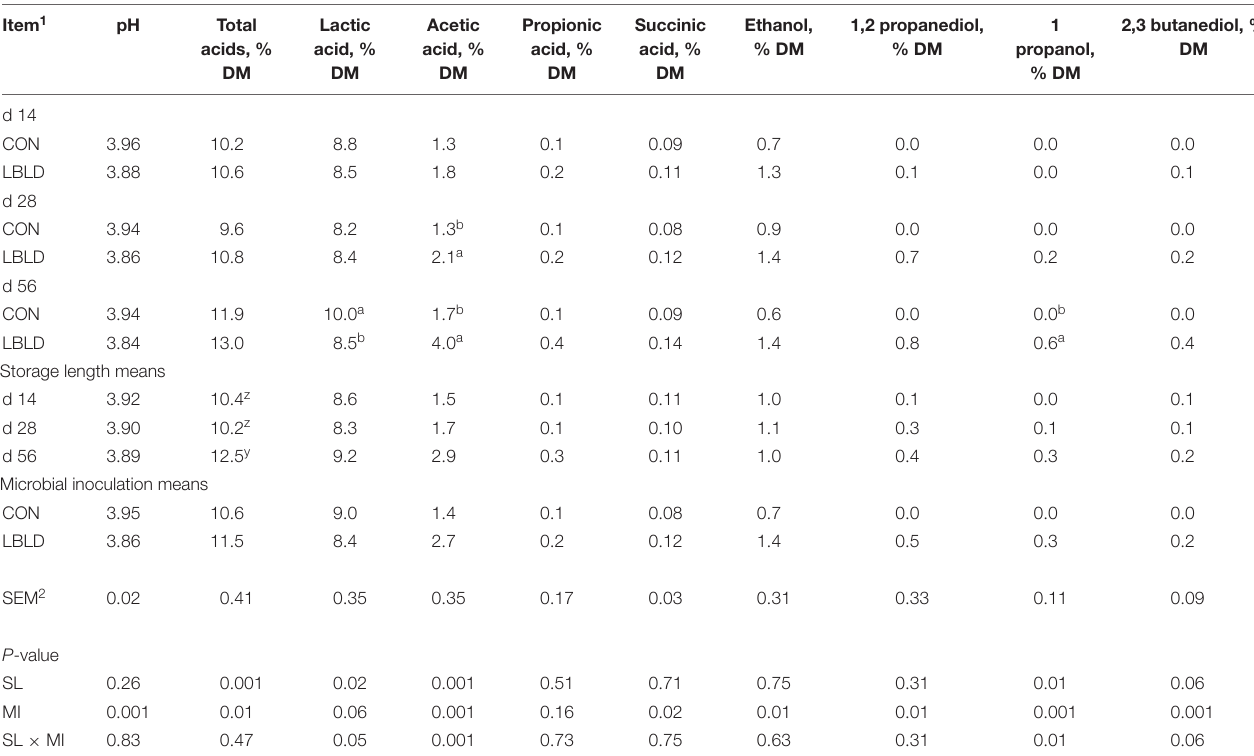
TABLE 2 | Effect of microbial inoculation and storage length on the fermentation profile of whole-plant sorghum silage in experiment